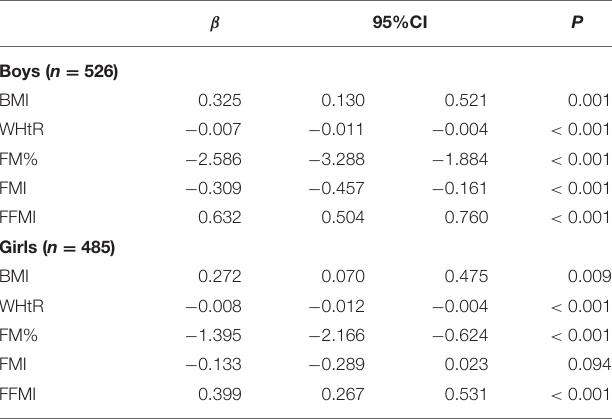
TABLE 3 | Trend of body composition indices changed with age by linear regression analysis.